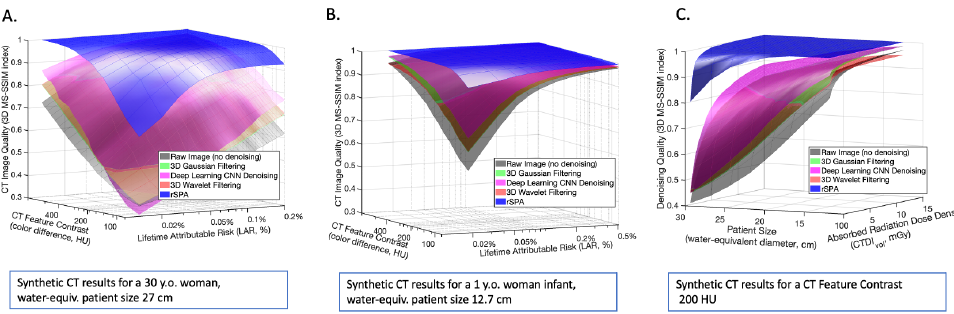
Figure 7. Comparing denoising methods with the average Multiscale Structural Similarity Index (3D MS-SSIM): ( A ) varying the true underlying feature contrast and LAR for a synthetic 30-year-old female patient with a water-equiv. cross-section of 27 cm; ( B ) varying the true underlying feature contrast and LAR for a synthetic 1-year-old female infant patient with a water-equiv. cross-section of 12.7 cm; ( C ) denoising performance comparison when varying the patient size and the effective absorbed radiation dose density, with the 200 Hounsfield Units (HU) feature contrast